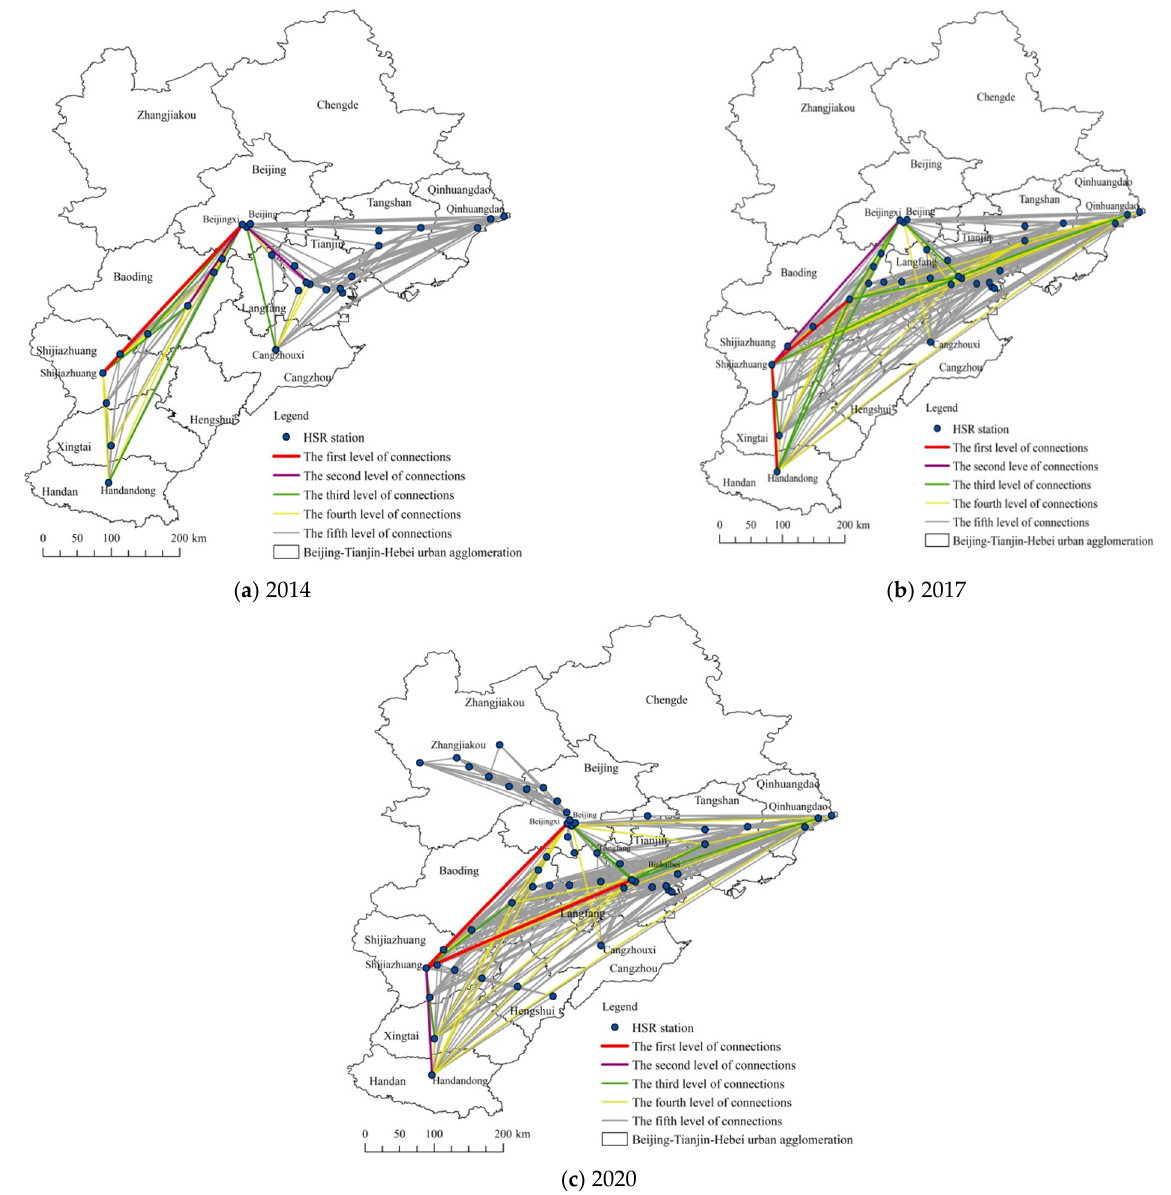
Figure 6. Network connection between HSR stations.